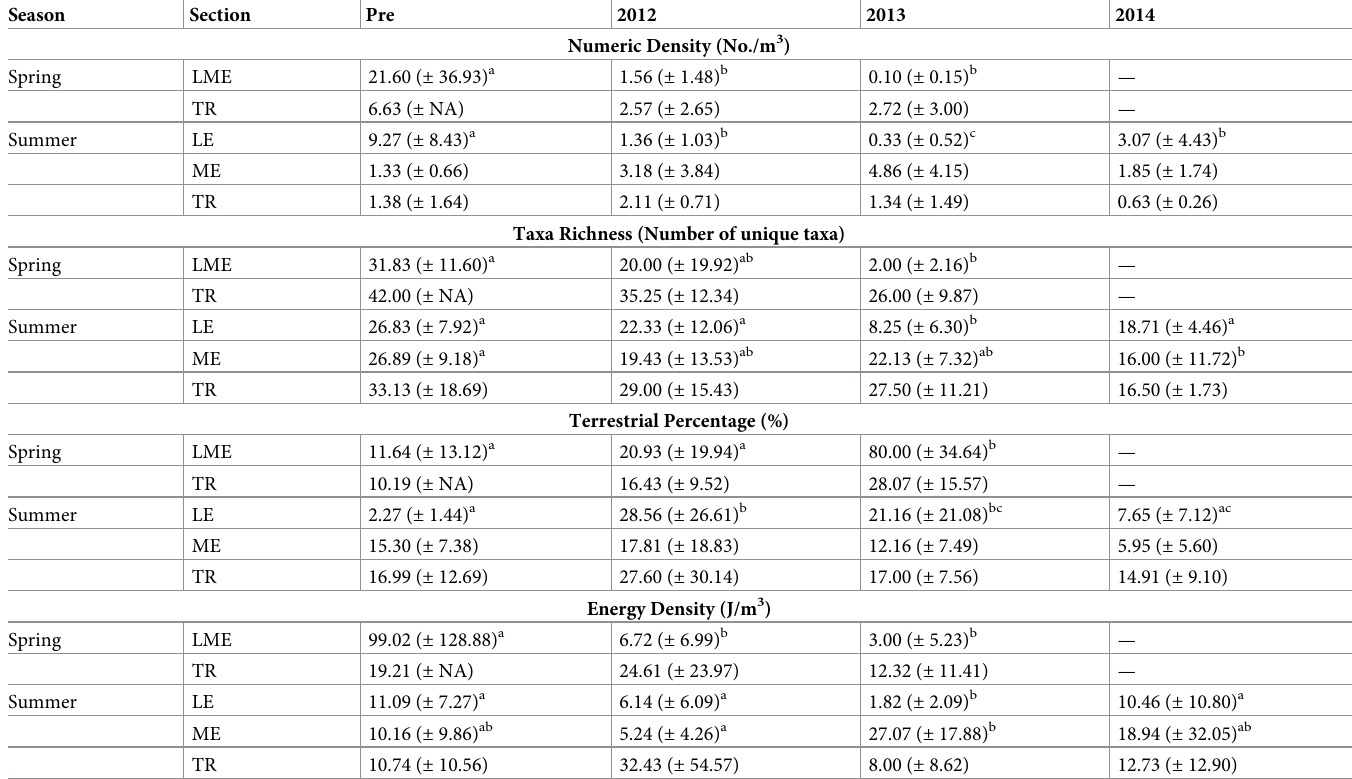
Table 4. Univariate metrics (mean values ± 1 SD) from river invertebrates collected by drift